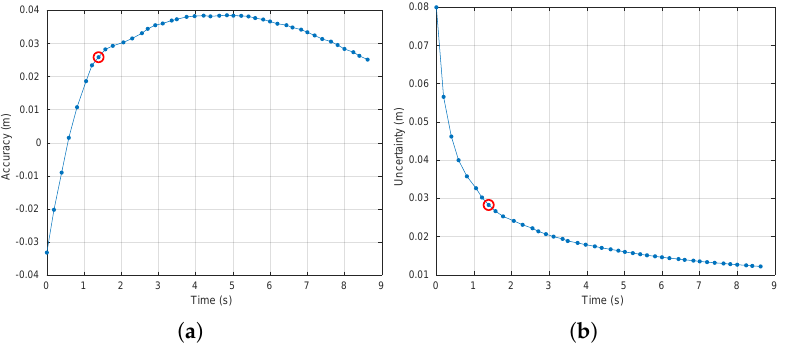
Figure 9. Evolution over time of the measures of filtering performance for the case of use of the Kinect sensor. The red circle indicates the instant of convergence (after 8 filtering steps). ( a ) Accuracy. ( b ) Uncertainty.